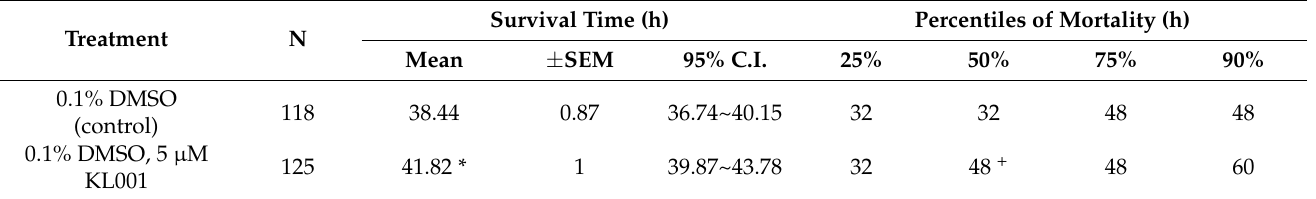
Table 1. Effects of KL001 on Drosophila melanogaster males’ survival under starvation conditions.